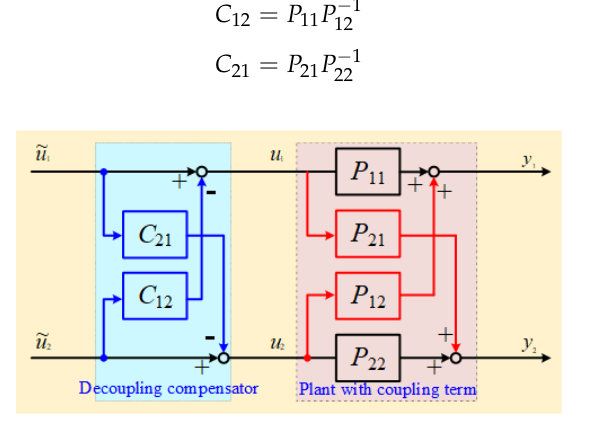
Figure 6. Block diagram of decoupling compensation.